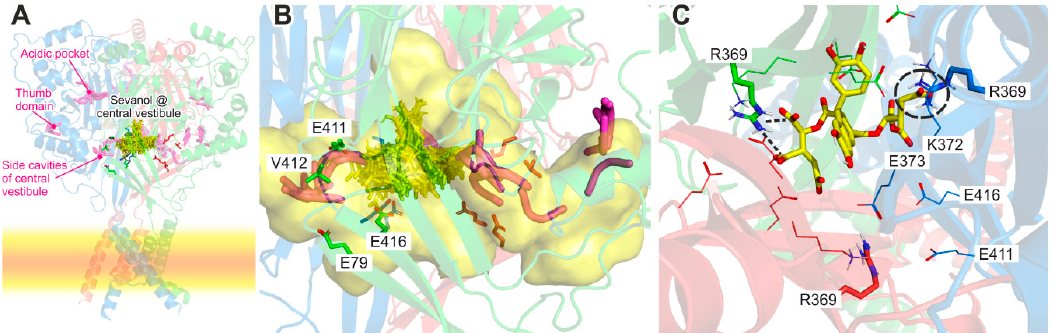
Figure 4. Sevanol docking into rASIC1a ( A – C ) (PDB ID 5WKU), and a comparison with FRRFa docking ( A , B ). ( A ) The semi-transparent cartoon shows the closed rASIC1a channel model; each subunit is individually colored, and the the membrane is schematically depicted with a yellow stripe. The yellow sticks represent 20 sevanol docking solutions inside the central vestibule. Magenta tubes depict the docking results for the FRRFa peptide (obtained from [37]), revealing three probable binding sites per subunit (the so-called acidic pocket, the pocket at the bottom of the thumb domain, and the central vestibule side cavities). ( B ) Close-up view of ( A ) with the central vestibule cavity shown as a semi-transparent yellow surface. Several channels’ residues, which are important for FRRFa binding in the central vestibule (as confirmed by mutagenesis), are shown with sticks and subscribed. One can note the partial overlap of the sevanol and FRRFa binding sites. ( C ) The sevanol binding site (solution #3) inside the central part of the vestibule (view from the top of the ASIC1 trimer). Arg369 is shown with sticks, other residues with lines. The probable salt bridges between the sevanol carboxyl groups and two Arg369 residues are depicted by dashed lines and a circle.